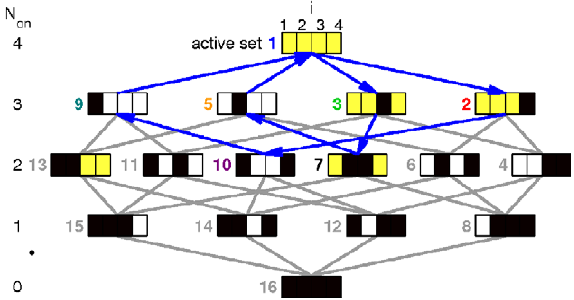
Figure 5. Tree of active sets. Tree of all existing active sets s for system shown in article Fig. (3). In set 1 all x i w 0 , yellow background stand for complex leading eigenvalues of the active interaction matrix. Black indicates that the agent associated with that index is not active. The gray lines indicate to all possible switching events where the number of active agents N act changes + 1 . Blue arrows mark the observed sequence of the dynamics for the examples Eq. (8) with D ~{ A ii ~ 0 : 14